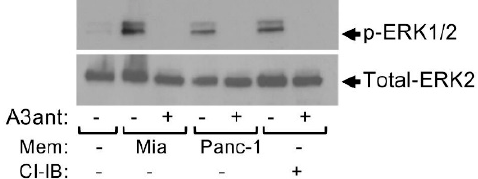
Figure 3. Pancreatic cancer cell derived membranes stimulate ERK1 / 2 phosphorylation in MCs in an adenosine A3 receptor-dependent manner. LAD2 cells (1 × 10 6 cells / mL) were incubated for 30 min in the absence or presence of the A3R antagonist MRS1220 (A3ant, 100 nM), as indicated. Cells were then left untreated or treated for 1 min with either membrane (50 µ g / mL) derived from Mia PaCa-2 pancreatic cancer cells, or Panc-1 pancreatic cancer cells, or with Cl-IB-MECA (Cl-IB, 100 nM), as indicated. Cell lysates were resolved by SDS-PAGE and immunoblotted with anti phospho-ERK1 / 2 antibodies, followed by reprobing with anti-total-ERK2 as indicated. A representative blot is shown. “Reprinted from Cancer Letters, 397, Yaara Gorzalczany, Eyal Akiva, Ofir Klein, Ofer Merimsky and Ronit Sagi-Eisenberg, Mast cells are directly activated by contact with cancer cells by a mechanism involving the autocrine formation of adenosine and autocrine / paracrine signaling of the adenosine A3 receptor. 23-32, Copyright © 2017 with permission from Elsevier.”.